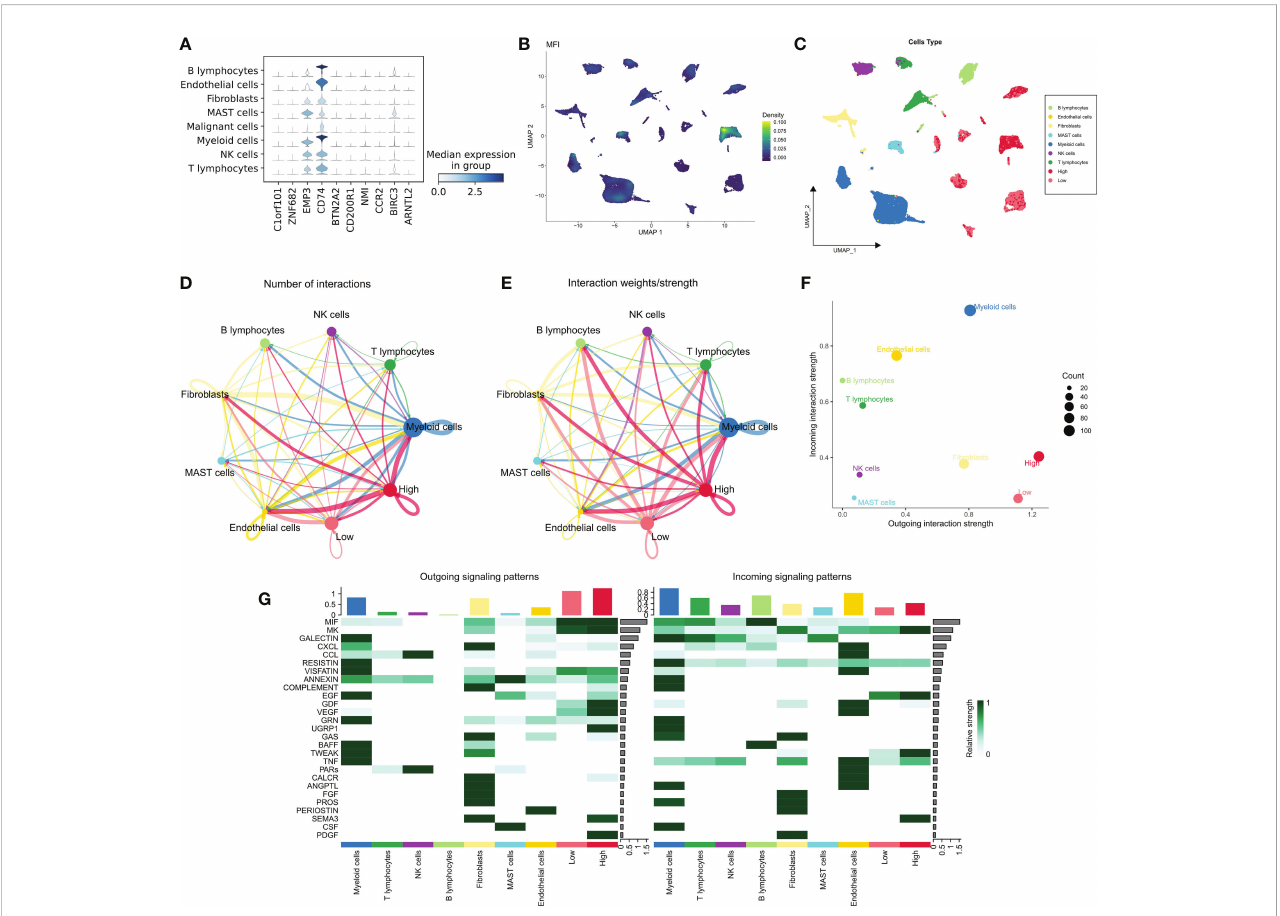
FIGURE 5 MFI at single-cell resolution. (A) Distribution of the model genes in different cells, showing that EMP3, CD74 and BIRC3 were widely distributed in immune-related cell populations and less expressed in malignant cells. The remaining 7 model genes were less expressed in all cell types; (B, C) Distribution of MFI in different cells. MFI was mainly distributed in a speci fi c group of malignant cells and most of the immune cells (B) ; we divided the malignant cells into high and low MFI groups based on MFI (C) ; (D, E) The cellular communication network of different cells. High MFI tumor cells had more receptor-ligand communications; (F) The number of communications in different cells, High MFI tumor cells receive and send more signals, indicating that these cells are more active; (G) Evaluation of speci fi c communication pathways. Our results showed that compared to low MFI cells, high MFI cells were more active in GDF, VEGF, SEMA3 and UGRP1